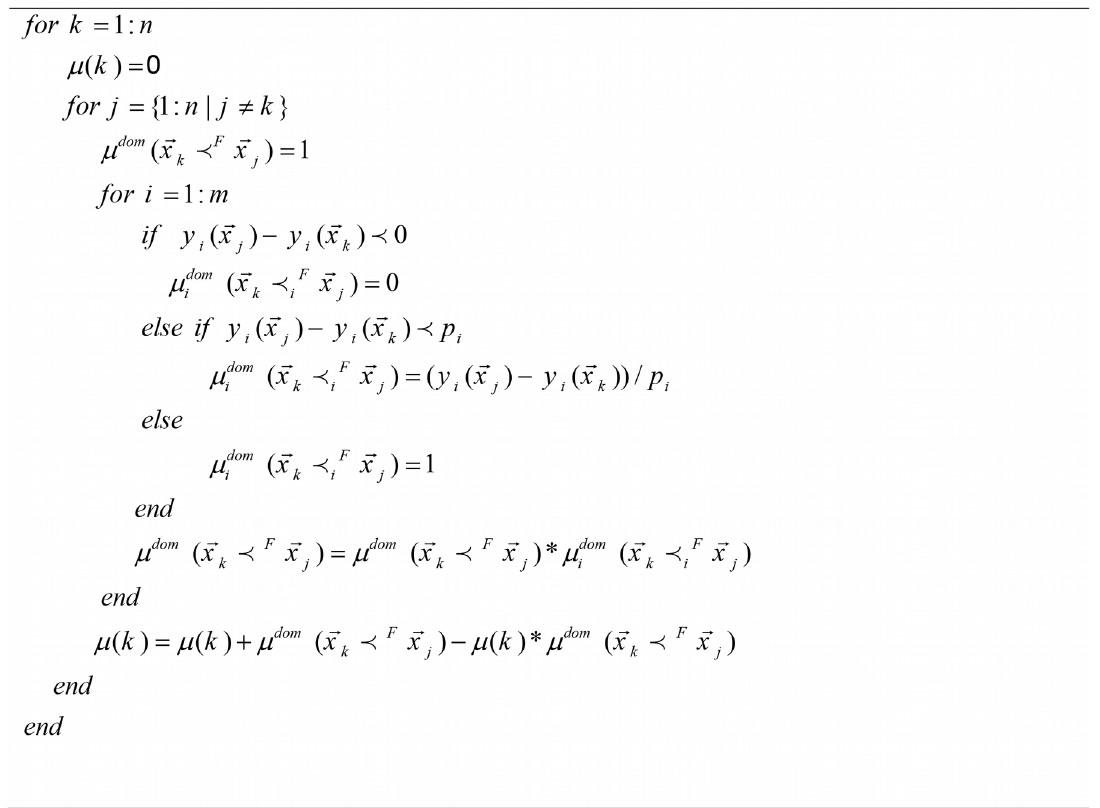
Figure 3. Pseudo-code algorithm for fuzzy